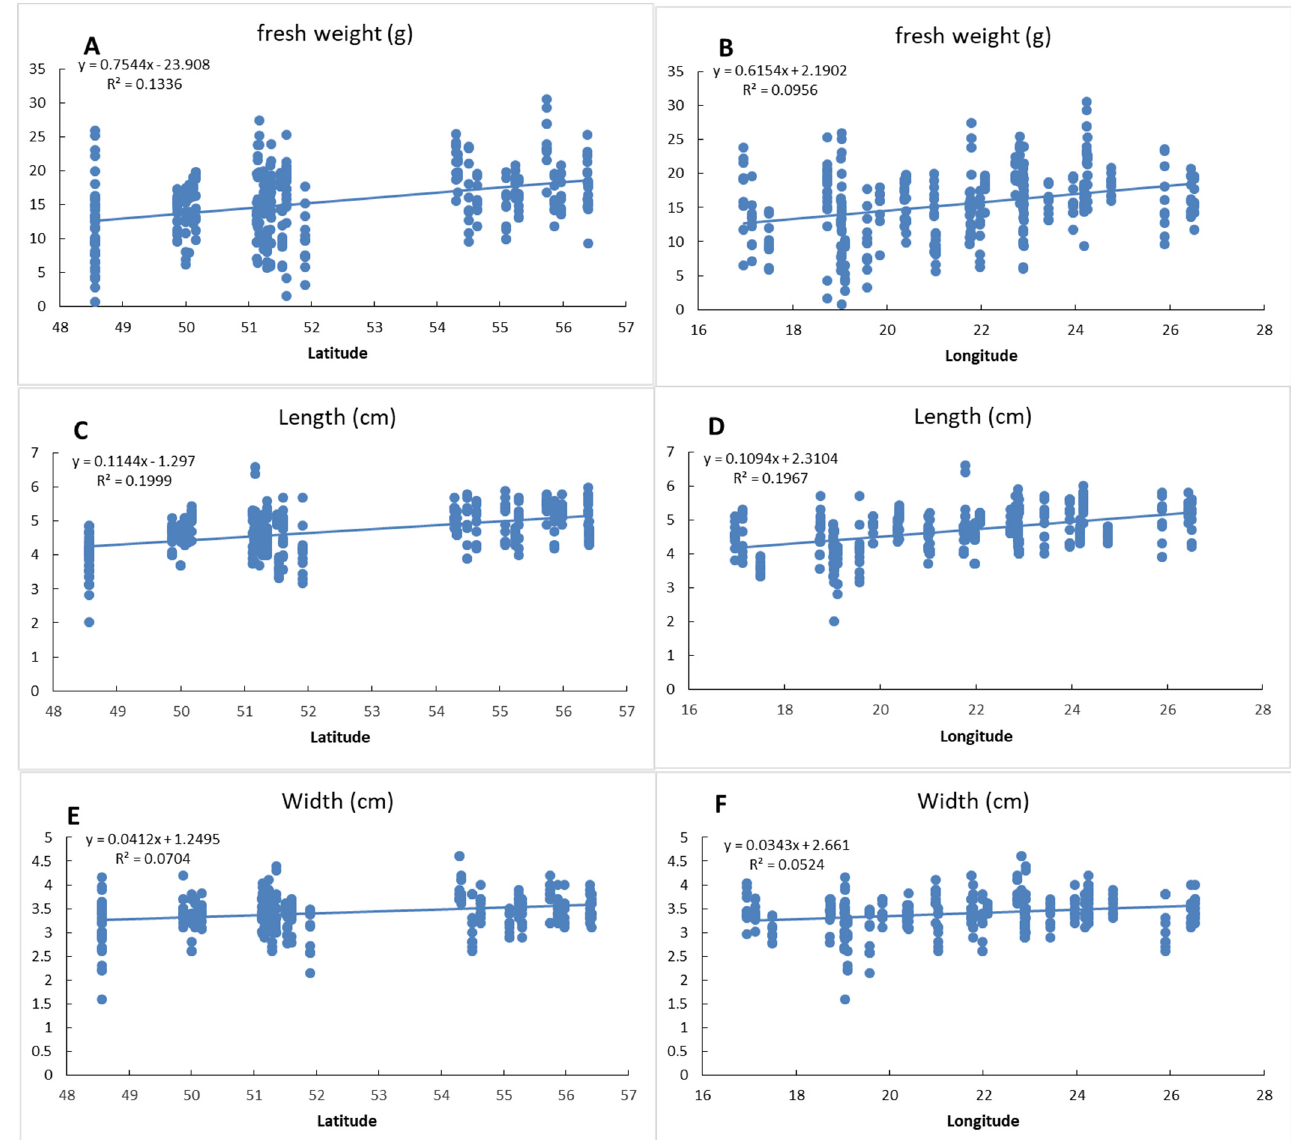
Figure 4. Correlation of fruit size of Echinocystis lobata with geographical position. The fruits from natural habitats ( N = 339) from Central Europe locations ( n = 34) for height level of 1.01–1.5 m. ( A , B )—fresh weight of fruits, ( C , D )—length of fresh fruits, ( E , F )—width of fresh fruits ( p < 0.005, F test).